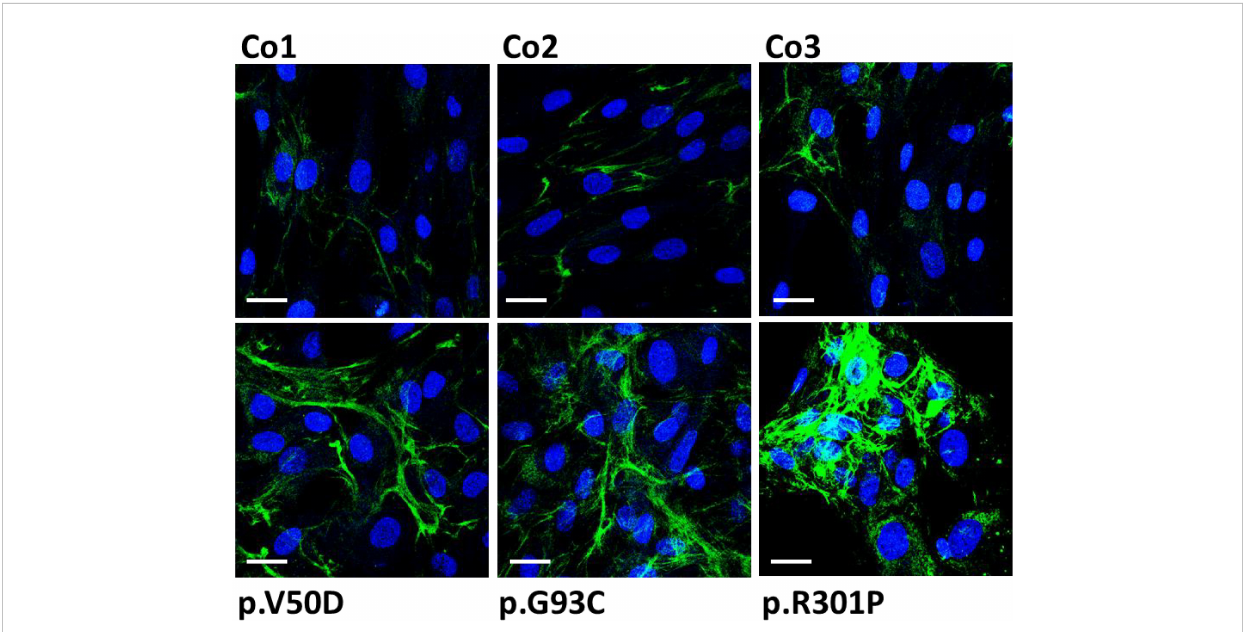
FIGURE 3 Fluorescence images showing F-CHP staining on human control (Co) and pEDS fi broblasts. Fixed cells were stained using a fl uorescence-labeled collagen-hybridizing peptide (CHP) which speci fi cally binds to denatured or fragmented collagen fi bers. In controls, F-CHP signals were weak indicating slow collagen I degradation. In patient fi broblasts, F-CHP was strongly increased with thick fi ber-like structures on the cell surface indicating large amounts of denatured collagen I fi laments. This fi gure is representative of four independent experiments. Scale = 20 µm.